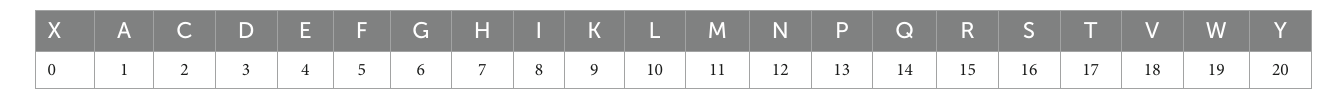
TABLE 1 Conversion between amino acid and